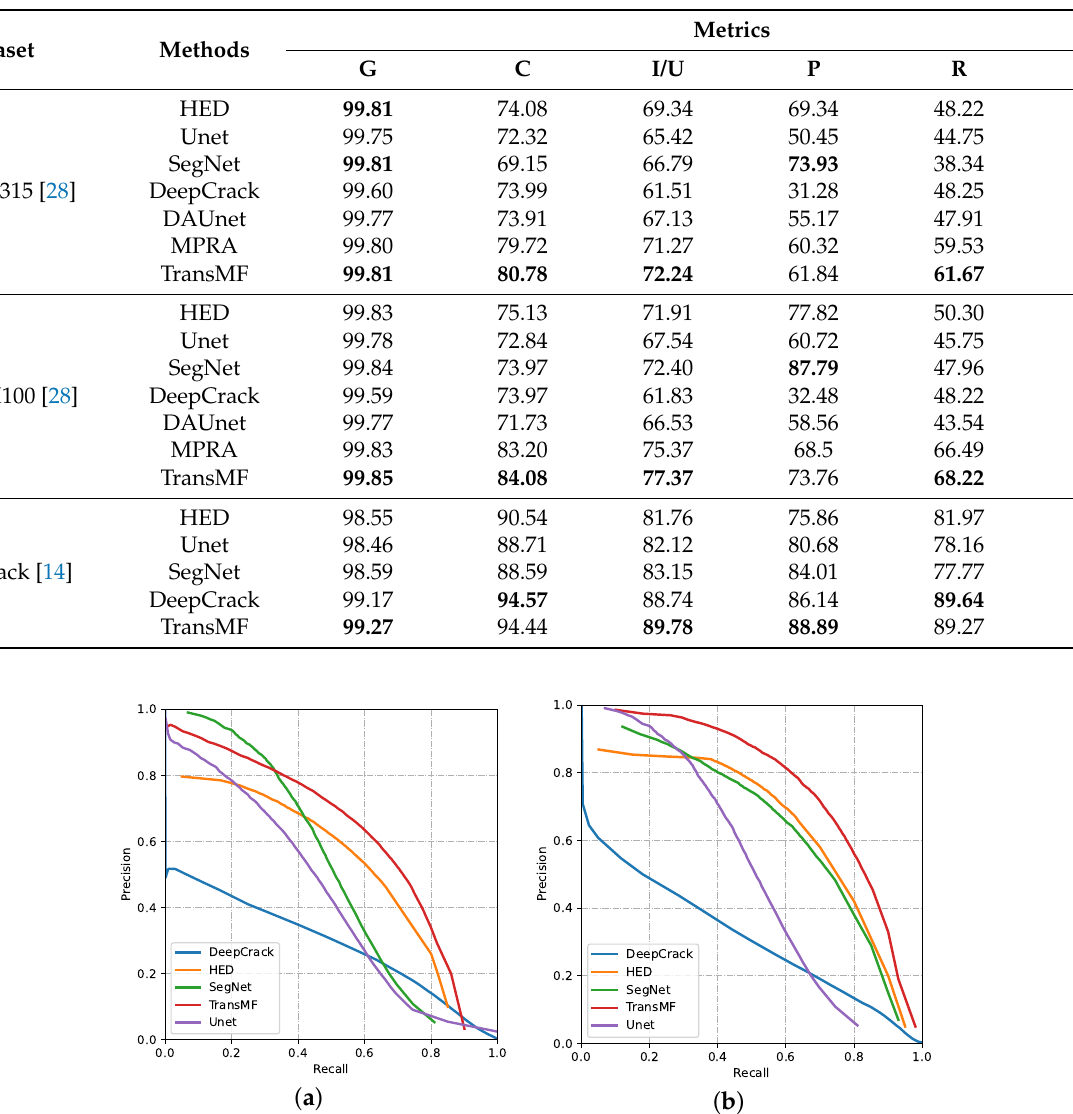
Figure 4. The Precision–Recall (PR) curve for crack detection. ( a ) on CrackLS315 dataset, ( b ) CRKWH100